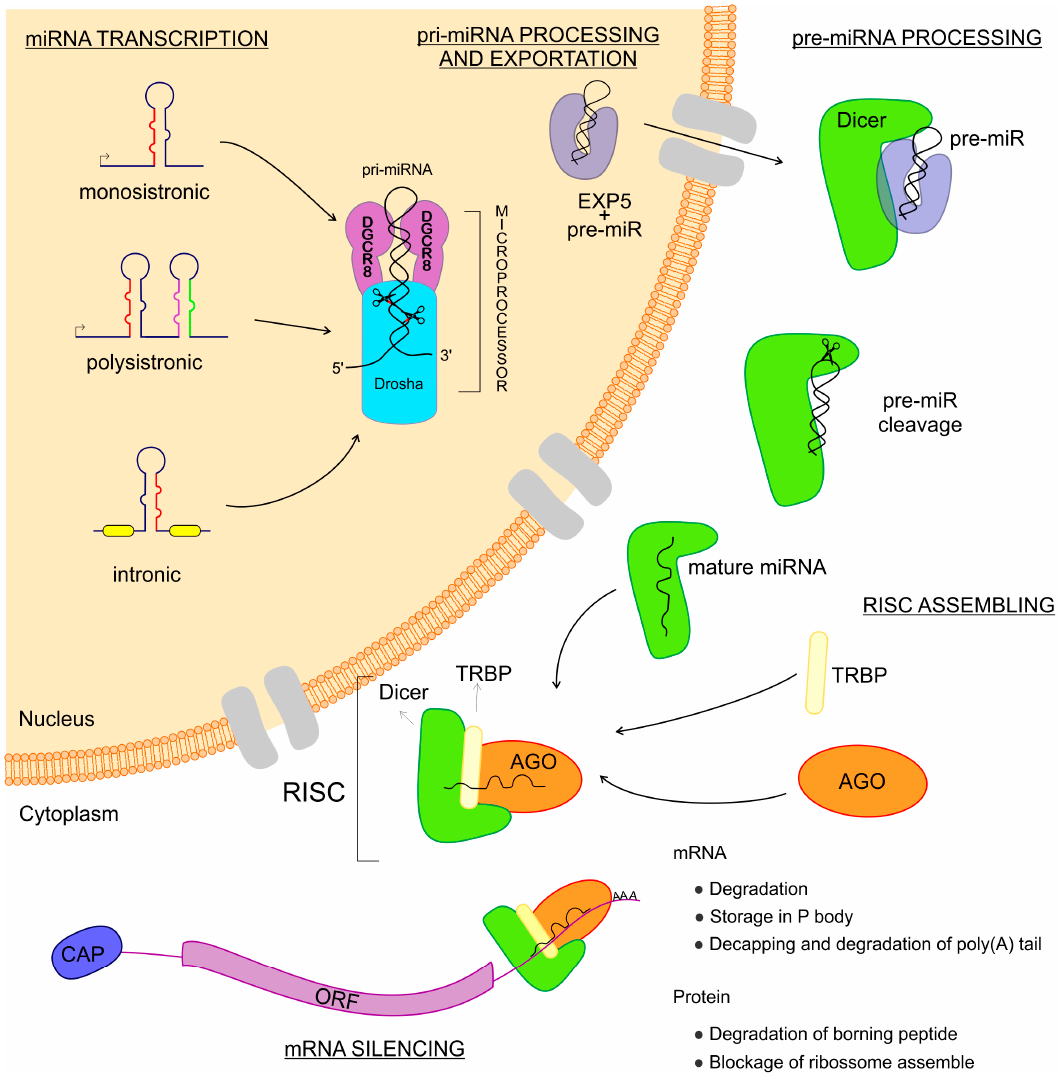
Figure 1. Biogenesis of microRNAs (miRNAs). The miRNAs are small non-coding RNAs transcribed from DNA sequences which can be monocistronic or polycistronic, comprised within exons, introns, or a unique host gene. Right after the transcription, this new RNA sequence is called primary-miRNA (pri-miRNA), which is folded in a hairpin conformation and coupled with the microprocessor: a combination of DGCR8 and Drosha RNases which cut the pri-miRNA, making it a pre-miRNA. Afterward, the pre-miRNA is coupled to Exportin 5 and then exported to the cytoplasm where this complex is found by Dicer, which cuts the pre-miRNA, releasing two mature miRNA arms. The mature miRNA complexed to the Dicer can now couple with the Argonaute and TRBP proteins, thus assembling the RNA Induced Silencing Complex–RISC. When the RISC is done, it can find the messenger RNAs that are the targets to the miRNA complexed. Once found, the message is now silenced and the gene expression regulated.